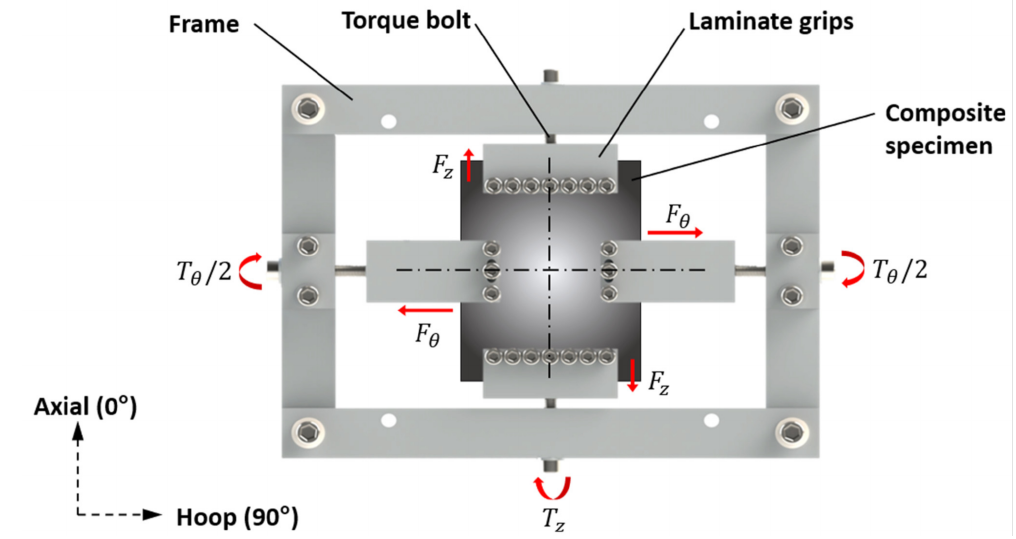
Figure 6. A schematic of the biaxial rig showing how the combined preloading is applied to the composite